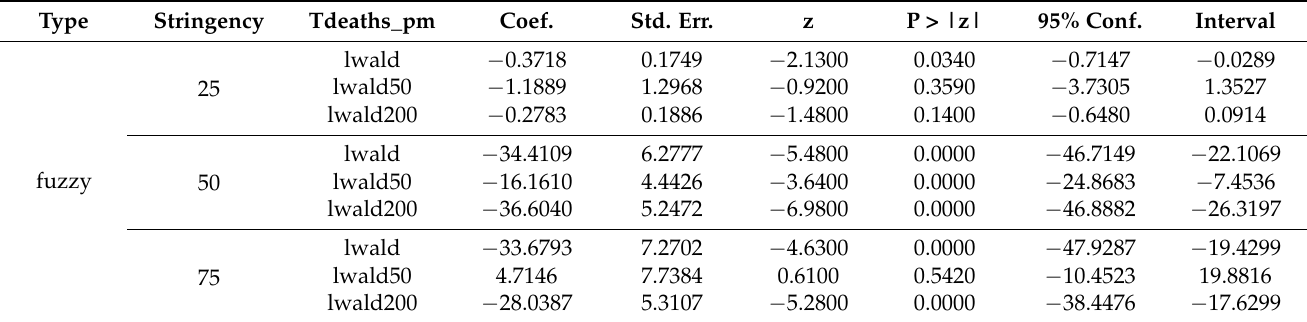
Table 6. Bandwidth dependence test of regression